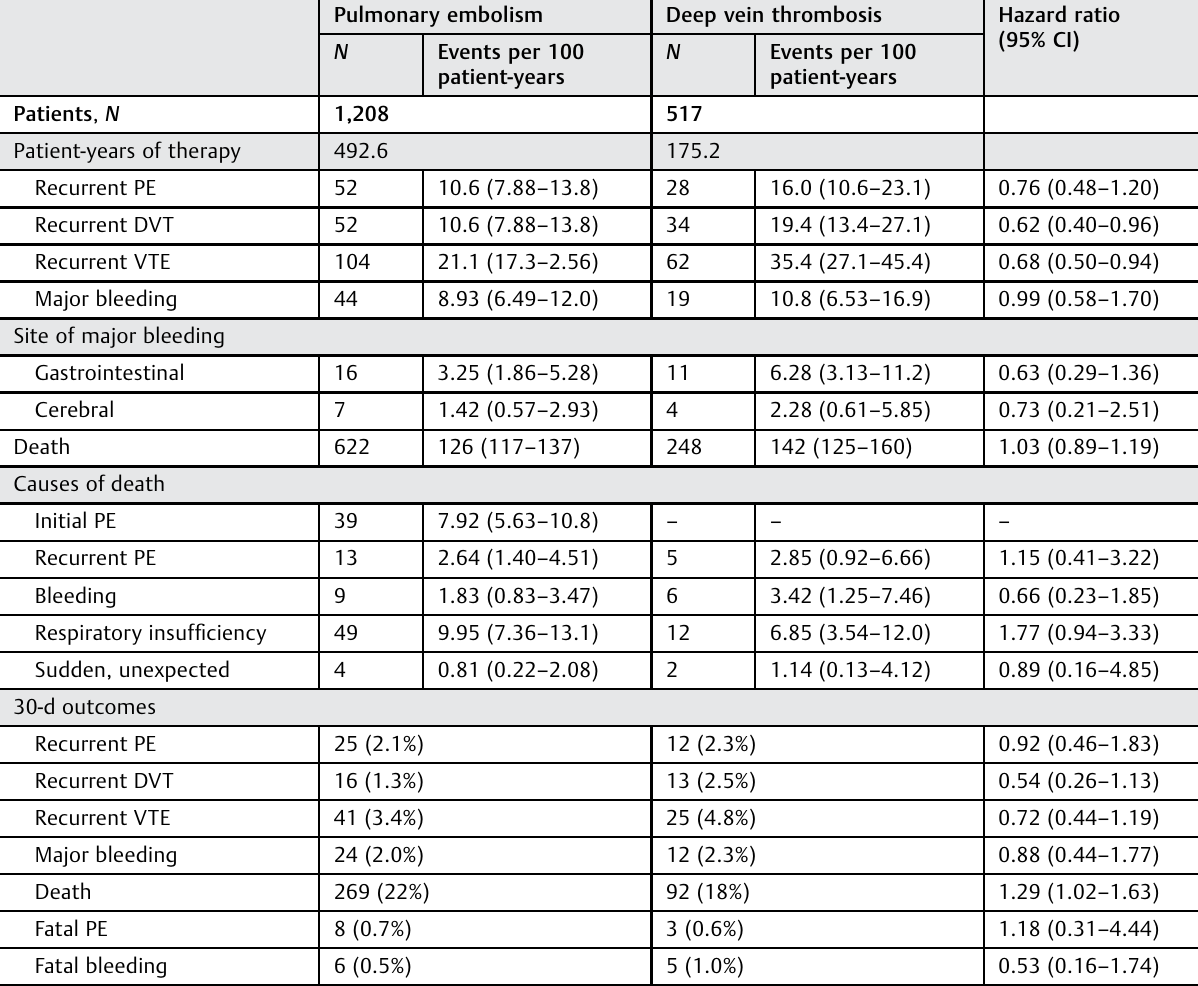
Table 3 Clinical outcomes during the course of anticoagulant therapy, according to initial VTE